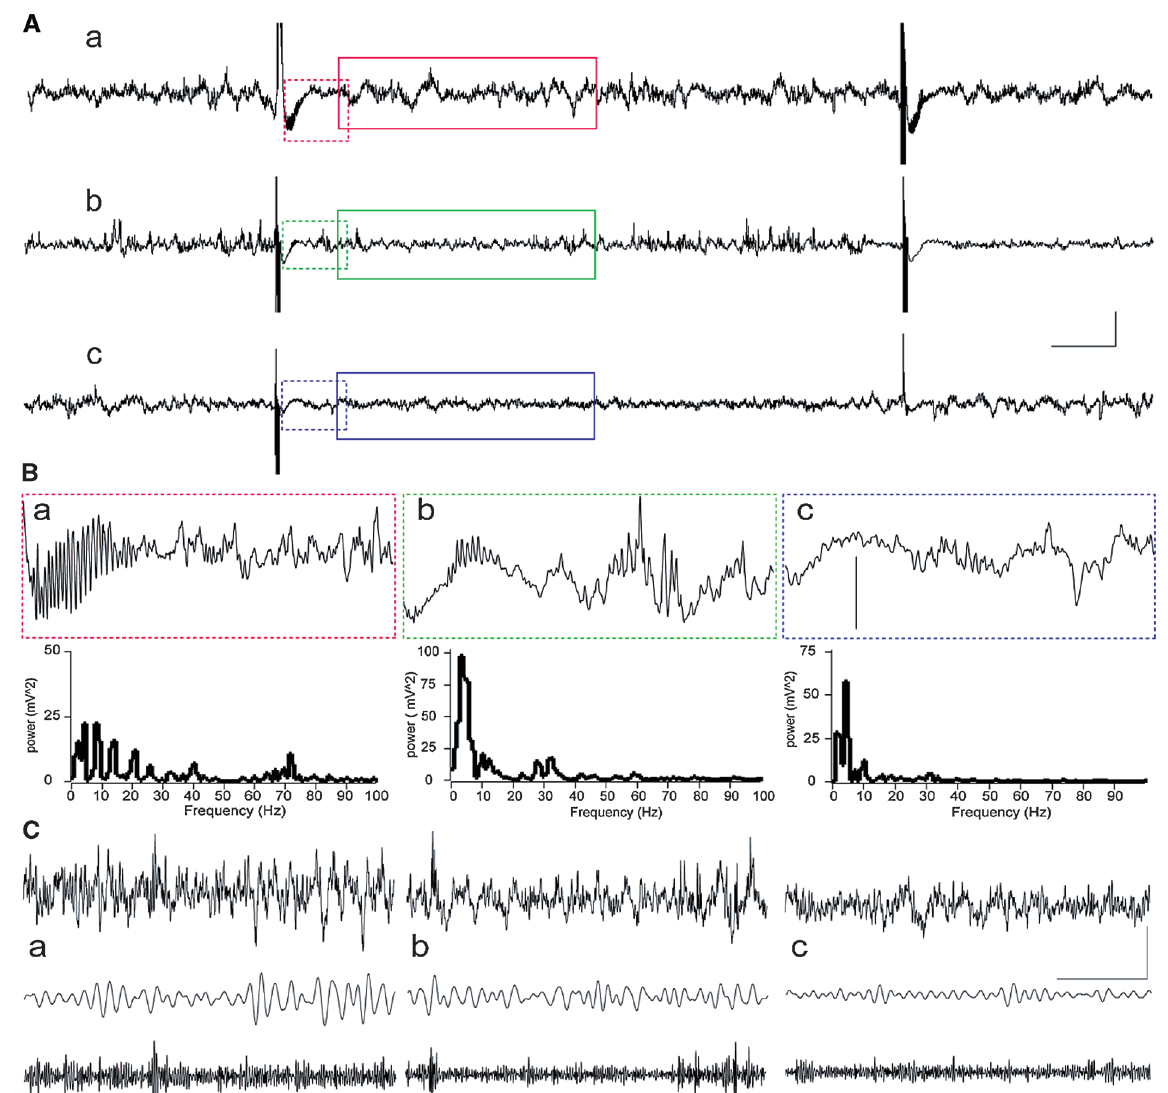
Figure 2. Examples of network activity in the DG during HFT. Raw records with two HFT bursts are shown resulted in LTP (a), STP (b) or failure of potentiation (c). ( A ) Examples of raw EEG containing two HFT trains delivered at a 10second interval in an animal that showed further LTP ( a ), STP ( b ) or failure of potentiation ( c ). Scale bars: vertical 0.25mV; horizontal 1second. ( B ) Representative examples of 1-second epochs cut immediately after HFT train and their power spectra (frequencies higher than 100Hz are not shown). Note a burst of evoked gamma oscillations, which are most prominent in case of LTP ( a ) than in STP rat ( b ), and are absent in FP rat ( c ). Vertical scale bar: 0.25mV. ( C ). An example of 4-seconds-long EEG epoch (upper trace), filtered activity in theta (5–10Hz) and gamma (30–100Hz) frequency ranges. Scale bars: vertical 0.25mV; horizontal